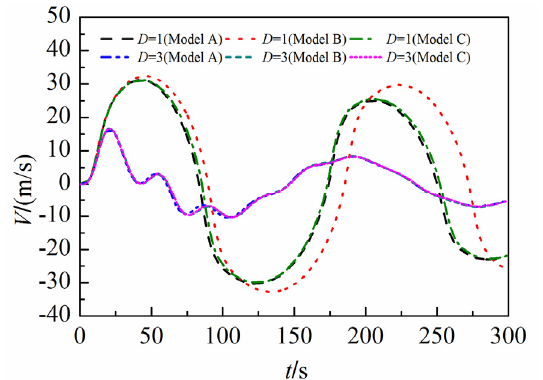
Figure 30. Gas pressure simulated by three models.